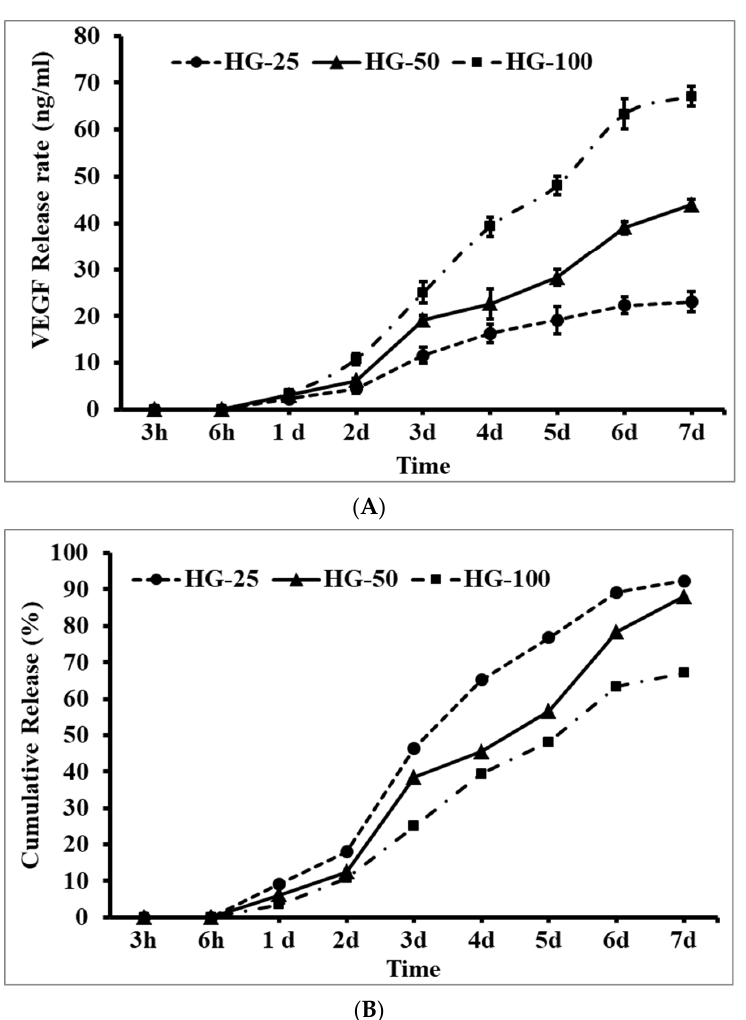
Figure 2. The release pattern of VEGF from hydrogels at different incubation times. ( A ) Actual release in ng/mL and ( B ) cumulative release in percentage. HG-25, HG-50, and HG-100—hydrogels with 25 ng/mL, 50 ng/mL, and 100 ng/mL of VEGF, respectively.